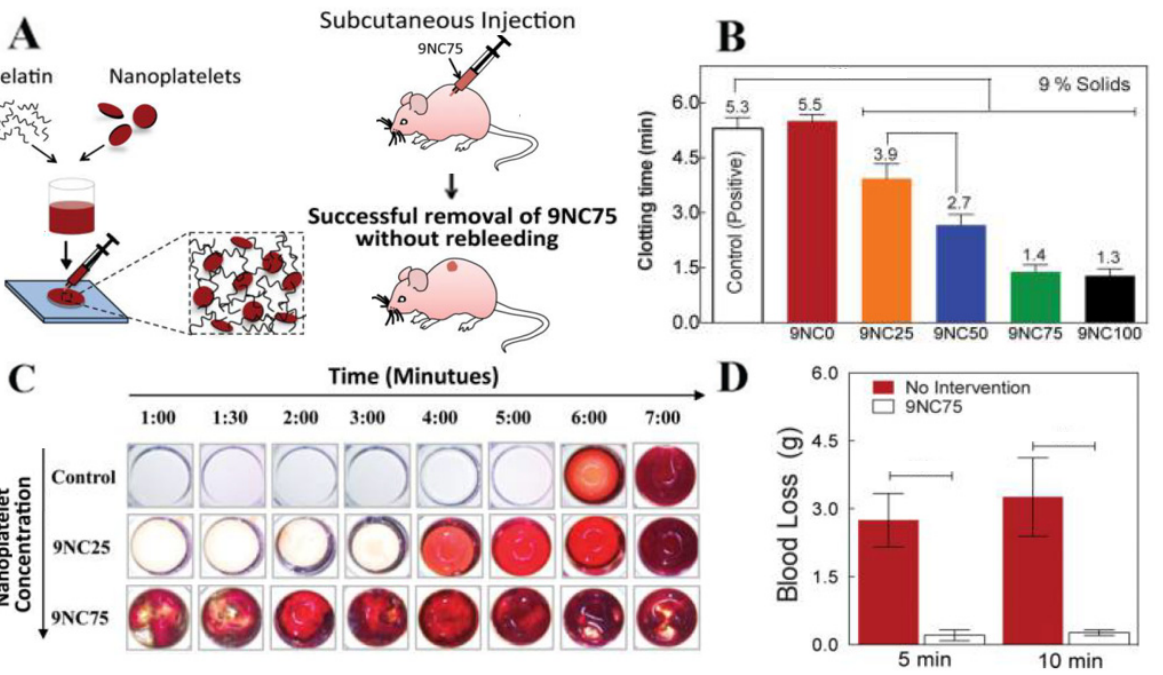
Figure 20 . ( A ) Preparation schematic of the hemostat nanocomposite gels, rat model subcutaneous injection, and posterior removal. ( B ) Effect of nanoplatelet addition on the blood clotting time. Quantitative clot times for 9% gelatin nanocomposites. ( C ) Clot formation as a function of time and nanocomposite composition (increasing nanoplatelet content). ( D ) Effective blood loss prevention relative to the untreated hemorrhage. (Adapted with permission from [114]. Copyright 2014, American Chemical Society).